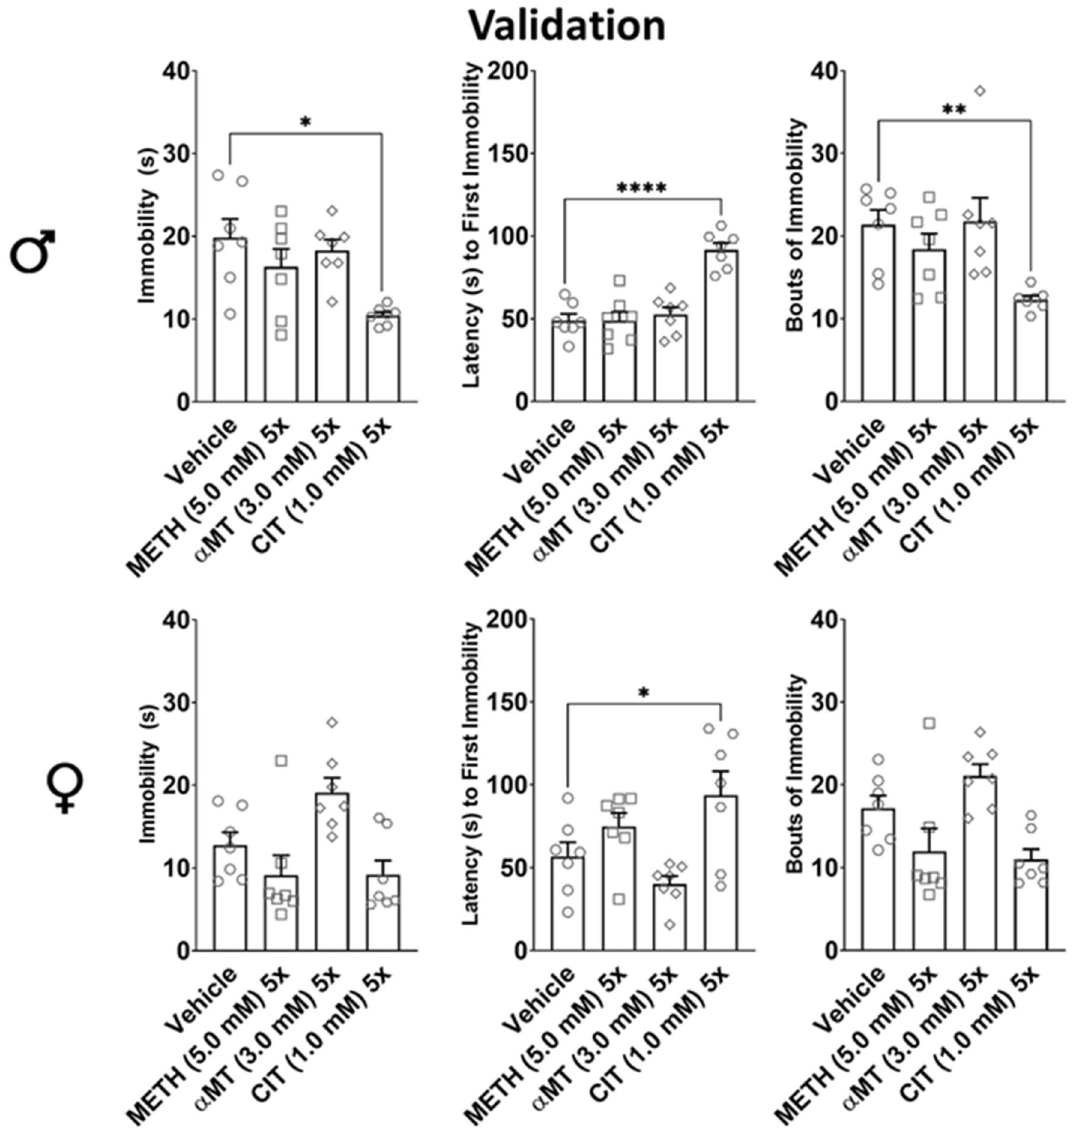
Figure 5. Locomotor activity as measured by DAMS for PSI, WAY, and KET. The changes in overall locomotor activity caused by low (0.03 mM) 1× and high (3.5 mM) 1× dose PSI were assessed, as were those caused by PSI (0.03 mM) 5×, WAY (1.0 mM) 5×, and KET (1.0 mM) 5×. Data were evaluated with 2-way ANOVA; * p < 0.05, ** p < 0.01, **** p < 0.0001. ( A ) Female PSI (3.5 mM) n = 15; all other groups n = 16. Control males were significantly less active than control females. 3.5 mM PSI significantly decreased locomotor activity in females. 3.5 mM and 0.03 mM PSI significantly increased locomotor activity in males. No other relevant differences were observed. ( B ) Female vehicle n = 15; all other groups n = 16. Control males were significantly less active than control females. KET significantly decreased locomotor activity vs vehicle in females vs vehicle and PSI (0.03 mM). PSI, WAY, and KET significantly decreased locomotor activity in males. Both sexes given KET were significantly less active than males given PSI. No other relevant differences were